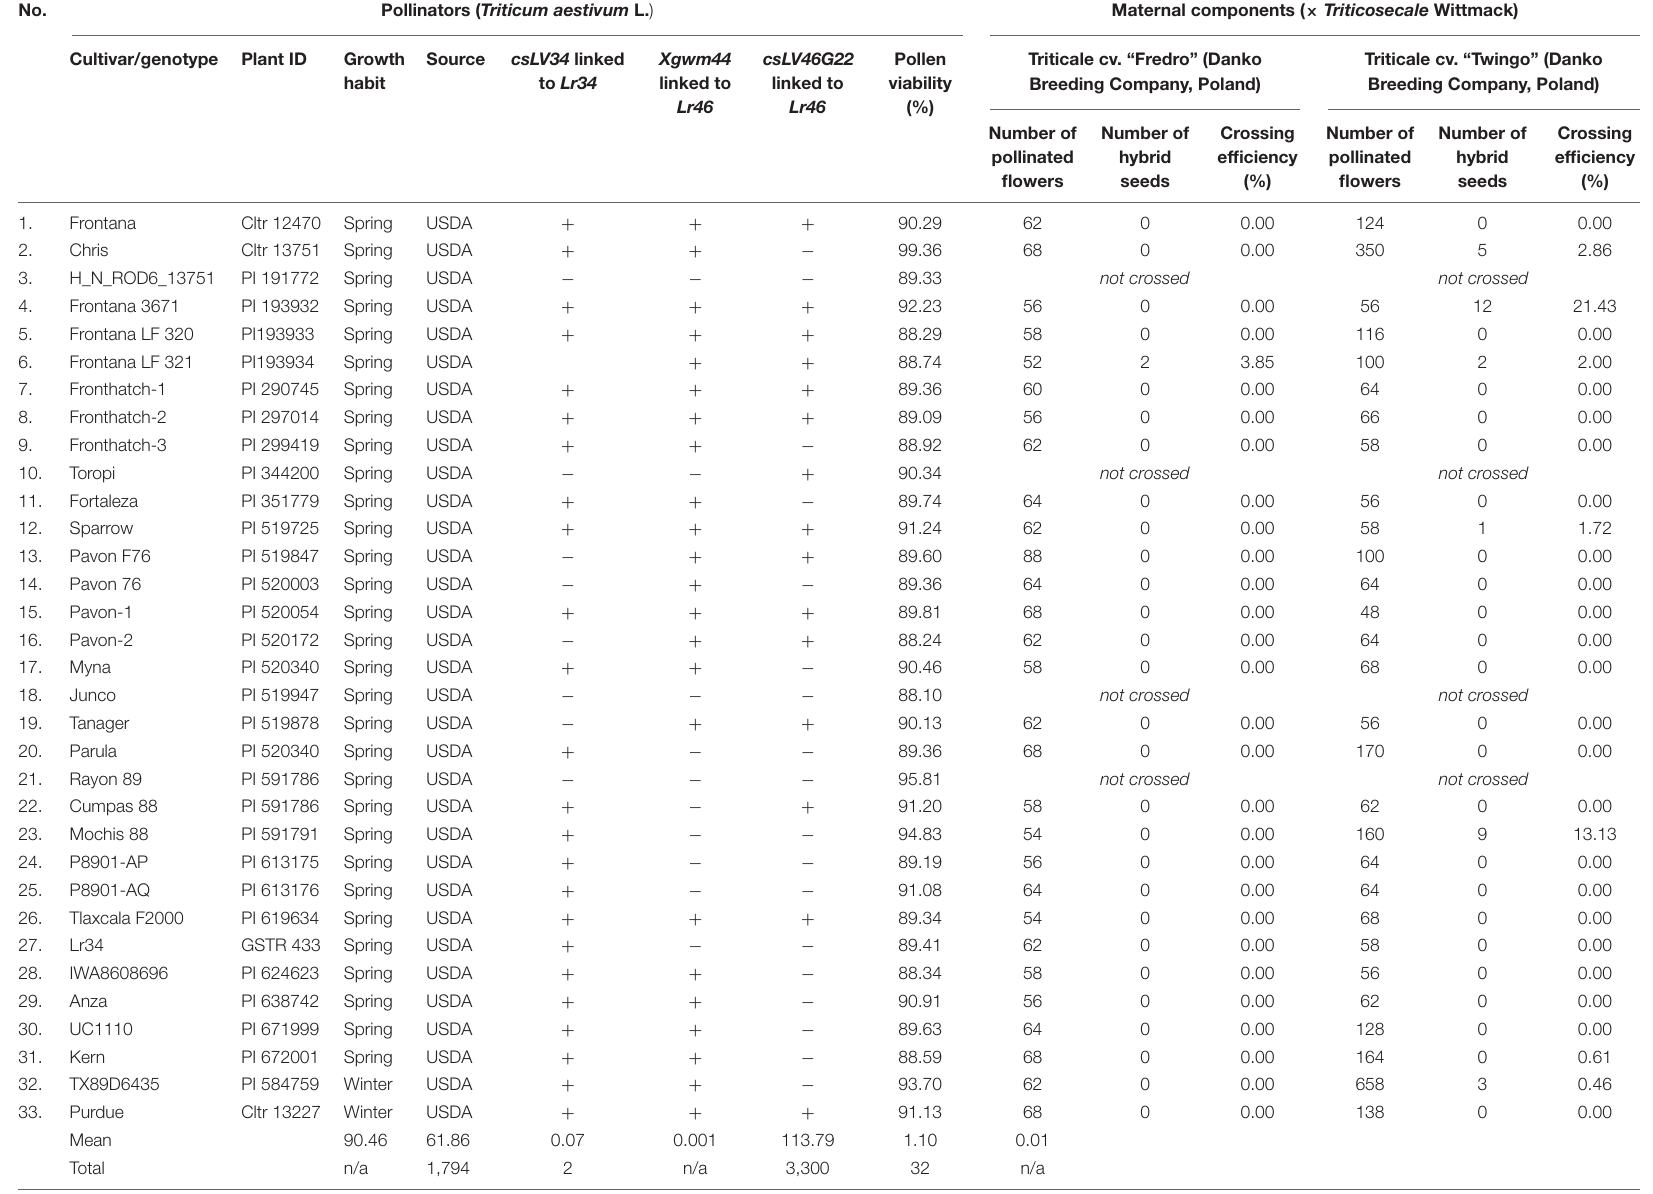
TABLE 1 | Pollen viability of wheat accessions and seed production ability of triticale after pollination with pollen grains from wheat components.